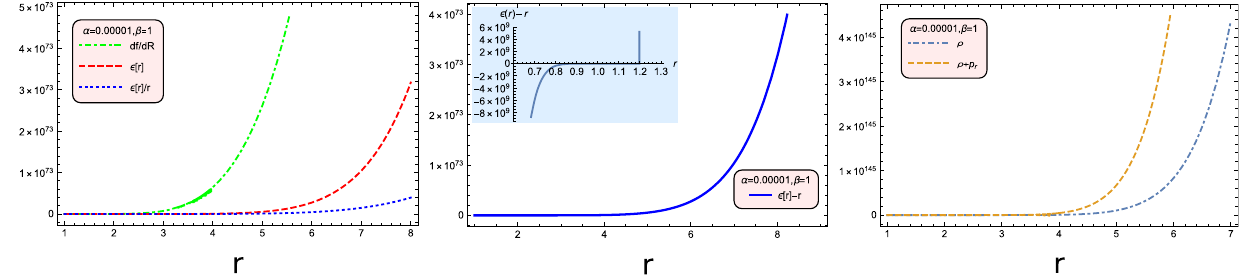
Fig. 7 First plot shows the behaviour of df / dR , (cid:6) and (cid:6) α = 0 . 00001 β = 1 for isotropic pressure. Second plot verify the posi- tion of throat at r 0 = 1 . 2 Km and third plot shows that NEC is respected